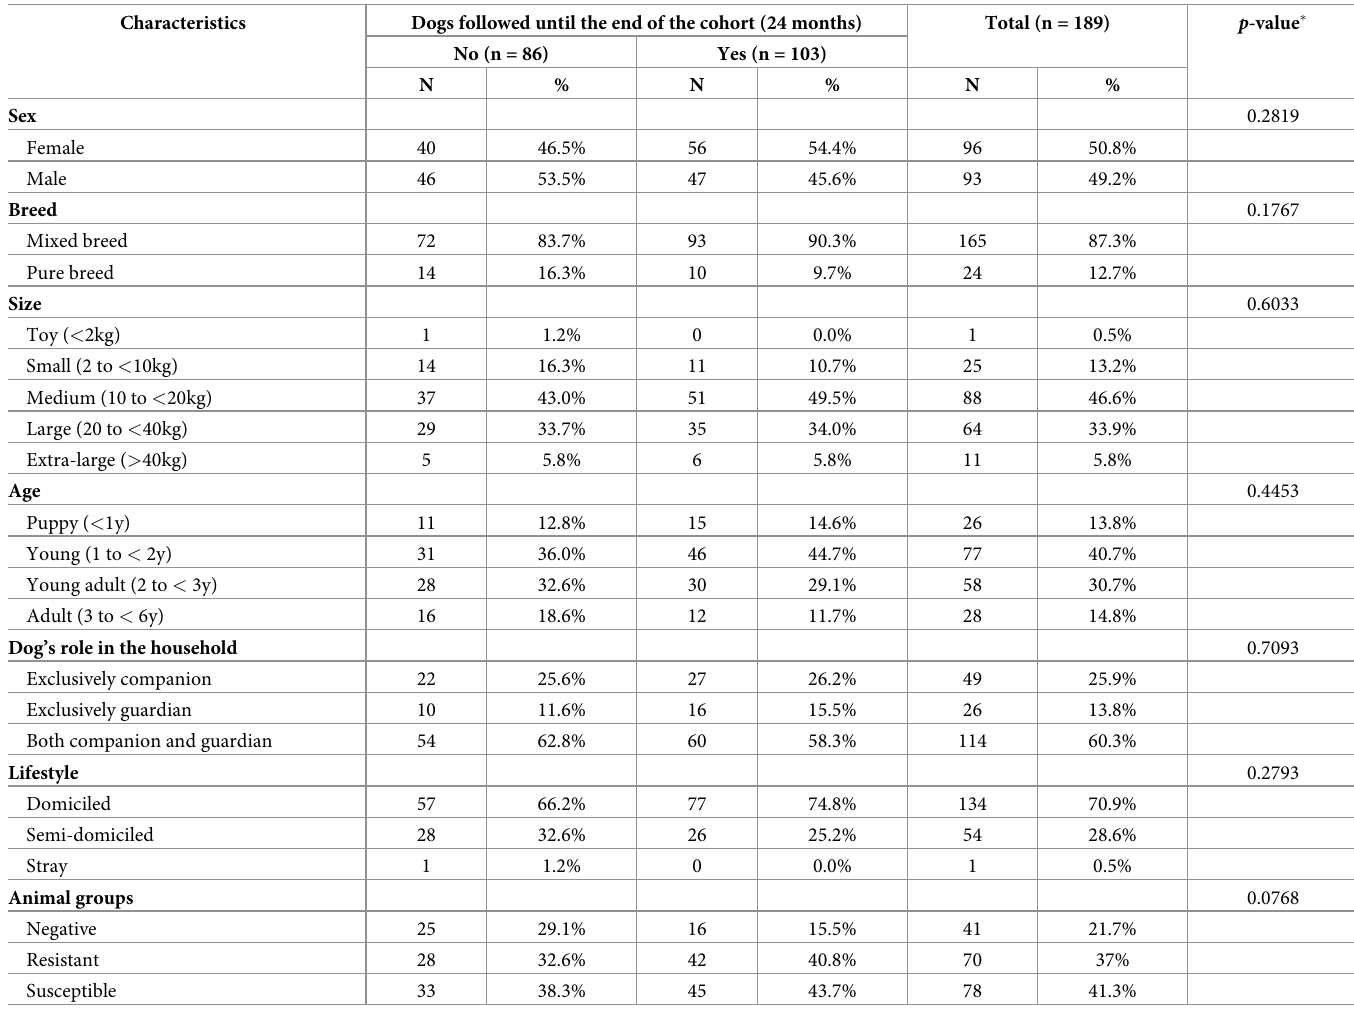
Table 2. Canine characteristics recorded at study baseline, and animal groups classified at the end of follow-up, discriminating dogs evaluated until the end of the cohort (24 months).